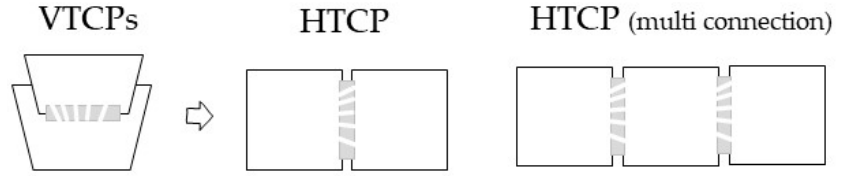
Figure 1. Redesigning the vertical-type co-culture plate to produce a horizontal-type co-culture plate (HTCP).